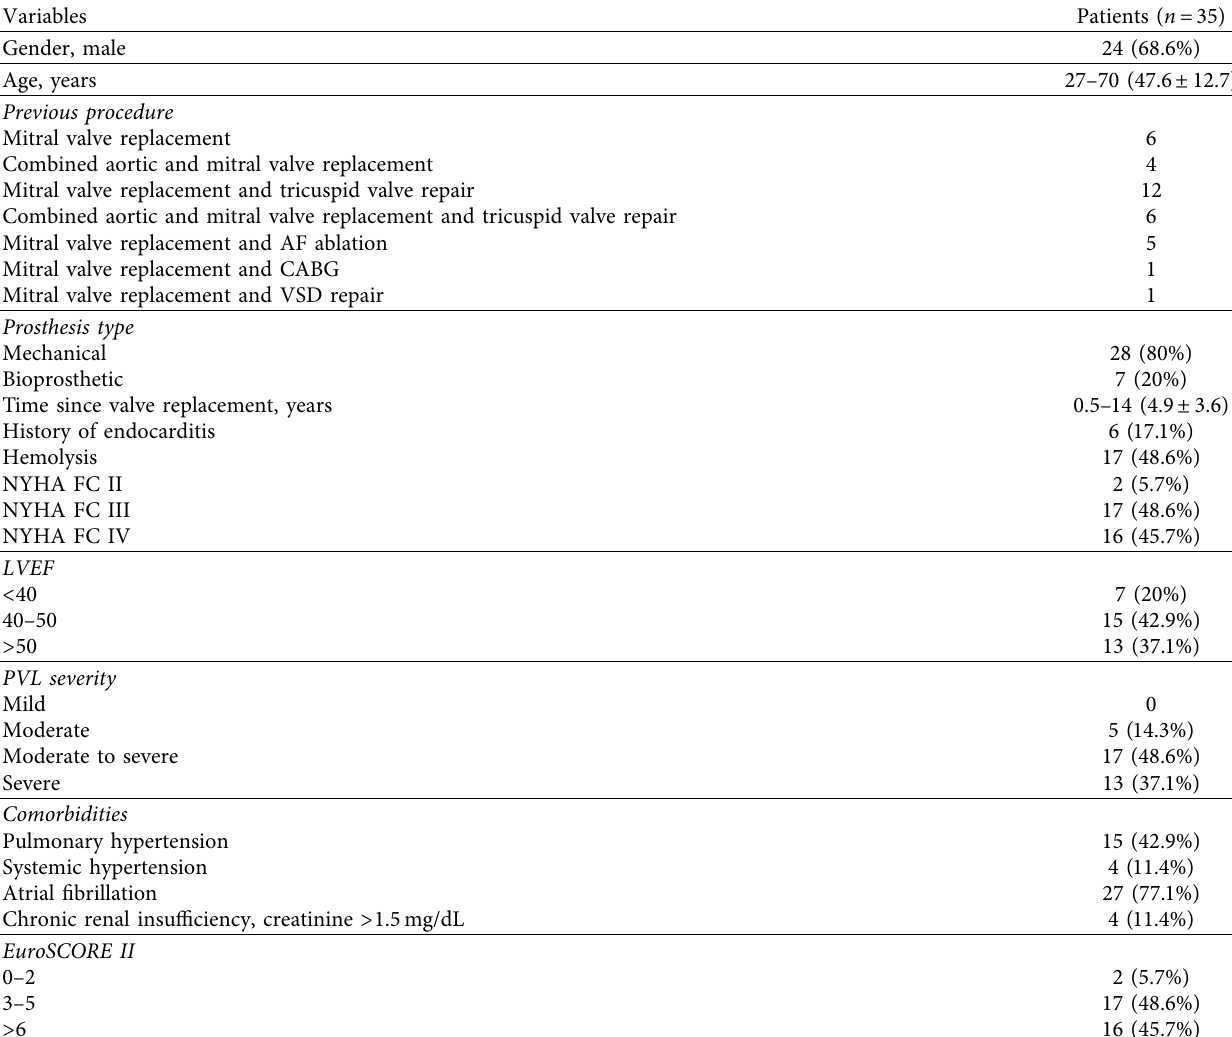
Table 1: Preoperative demographic and clinical